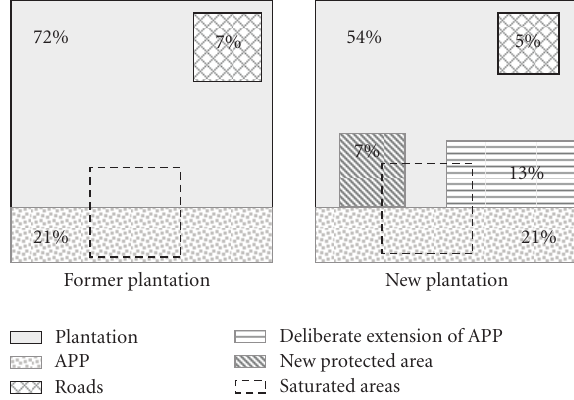
Figure 4: Scaled schematic representation of the catchment land use in the former in comparison with the new planting